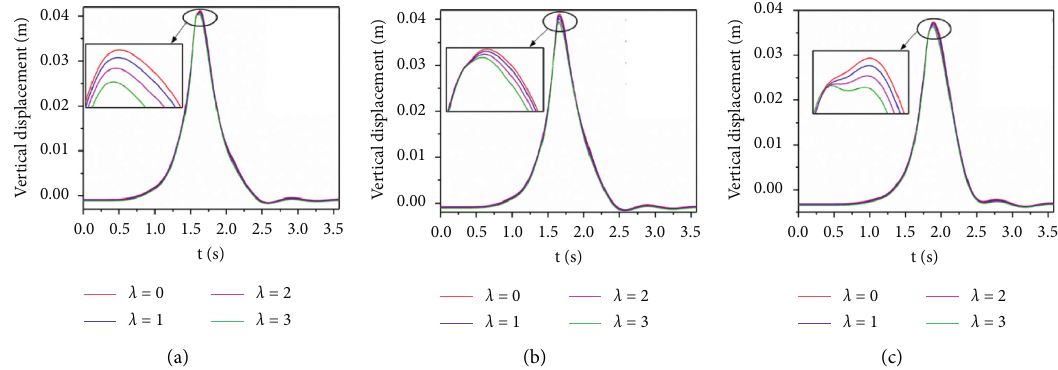
Figure 8: Characteristic curve of specific point (uniform load method). (a) Support positioning position. (b) The first dropper. (c) The mid- span.